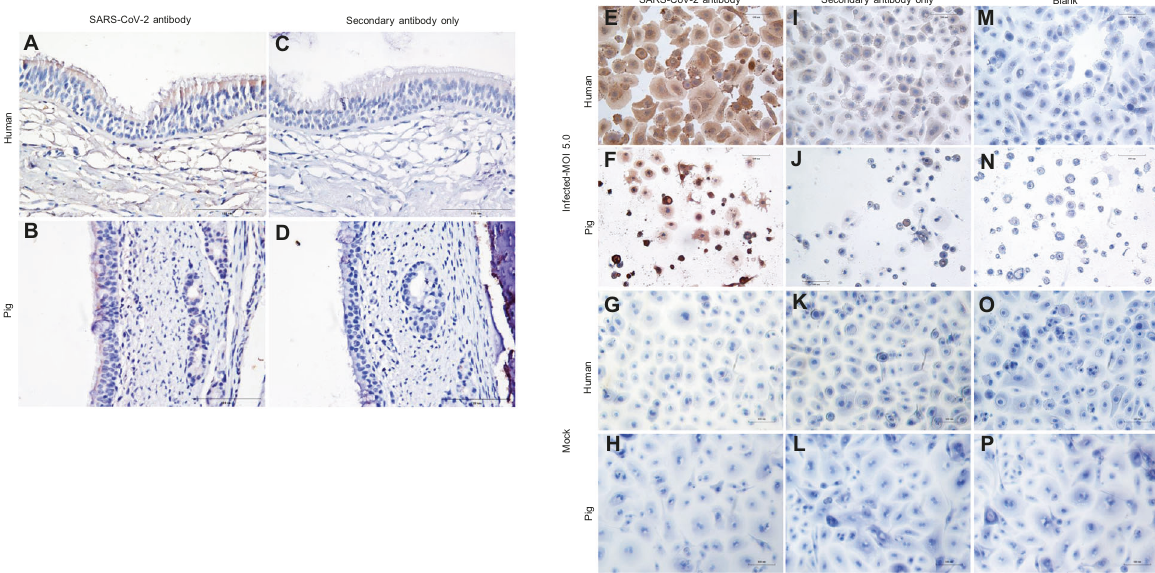
Fig. 2 SARS-CoV-2 binding on human and pig tracheal epithelium and infection in HRECs and PRECs. The tissues and cells presented in this panel were stained with ImmPRESS VR anti-rabbit IgG horseradish peroxidase (HRP) polymer detection kit (MP-6401-15) with a rabbit monoclonal antibody speci fi c for anti-SARS Coronavirus/SARS-Related Coronavirus 2 nucleocapsid (N) protein (0.75 μ g/mL) (the following reagent was obtained through BEI Resources, NR-53791). Dark brown spots represent a positive expression of viral N protein, and pale brown represents background staining, while the nucleus counterstained with hematoxylin is blue. A – D Representative images showing SARS-CoV-2 binding in formalin- fi xed paraf fi n-embedded cross-sections of A human and B pig trachea after overnight incubation with 250 μ L heat- inactivated SARS-Related Coronavirus 2, Isolate USA-WA1/2020 (the following reagent was obtained through BEI Resources; NR-52286). C Human ( n = 1) and D pig ( n = 3) tracheal epithelial sections were stained with secondary anti-rabbit HRP antibody only. E – P Detection of SARS-CoV-2 infection in HRECs and PRECs inoculated with SARS-CoV-2, Isolate USA-WA1/2020 at 120 hpi. Paraformaldehyde (4%) fi xed cells were stained for SARS-CoV-2 N protein. E , I , and M HRECs and F , J , and N PRECS were inoculated with a viral dose of MOI 5.0 or culture medium, as negative control ( G , K , and O for HRECs; H , L , and P for PRECs); ( n = 6). Scale bar — 100 μ and RT-qPCR. No signi fi cant differences in Ct values were observed between HREC and PREC virus-infected lysates (Fig. 5A) and supernatants (Fig. 5B) collected at 2, 12, 24, 48, 72, 96, 120 hpi. An average of six Ct increase was noticed between MOI 5.0 and 5.0 × 10 − 2 , while at MOI 5.0 × 10 − 4 , the Ct values were near or above the cut-off Ct value (35 cycles). In addition, IHC for SARS- CoV-2 N protein revealed the production of viral proteins in HRECs (Fig. 3B – D, H – J, and N – P) and PRECs (Fig. 3E – G, K – M, and Q – S) infected with SARS-CoV-2, being more evident at MOI 5.0 in both HRECs (Fig. 3B – D) and PRECs (Fig. 3E – G). In comparison, mock- inoculated HRECs (Fig. 3T – V) and PRECs (Fig. 3W – Y) stained negative.